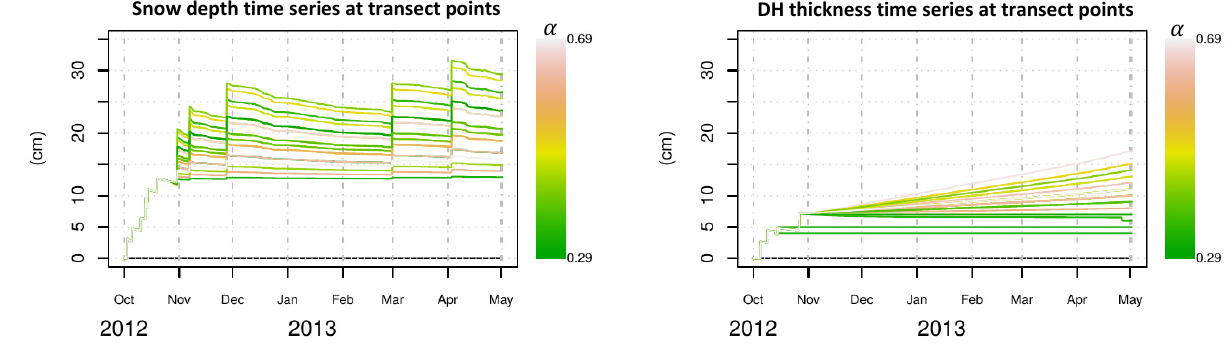
Figure B1. Constructed snow depth and DH thickness time series for each transect point. As in the paper, α is the DH thickness-to-total snow depth ratio at time t 2